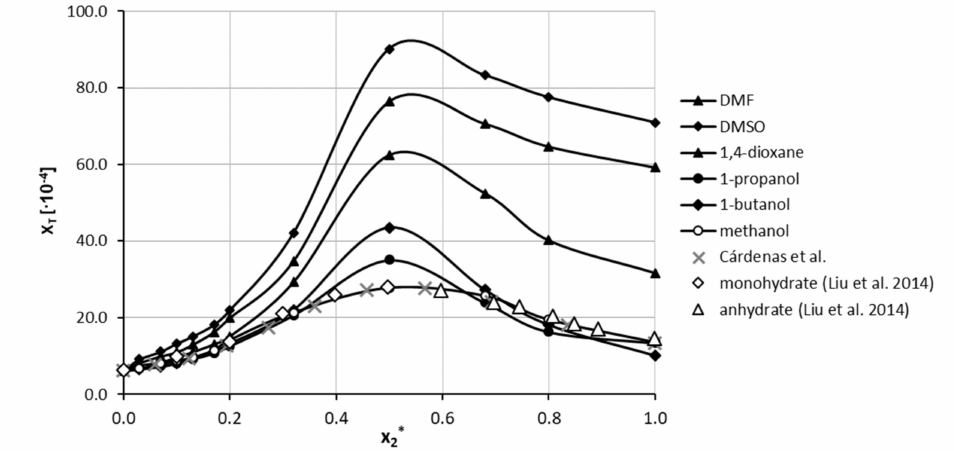
Figure 2. Solubility of theophylline at 25 ◦ C, expressed as its mole fraction, x T , in binary solvents comprising water and five different organic solvents in varying compositions. On the ordinate, x ∗ represents the mole fractions of organic solvent in solute-free binary solutions. The values 2 of Theophylline solubility in aqueous methanolic solutions published by C á rdenas et al. [85] were marked with grey crosses and are anhydrous. Additionally, monohydrate and anhydrate theophylline solubilities measured by Liu et al. [86] were plotted as open diamonds and